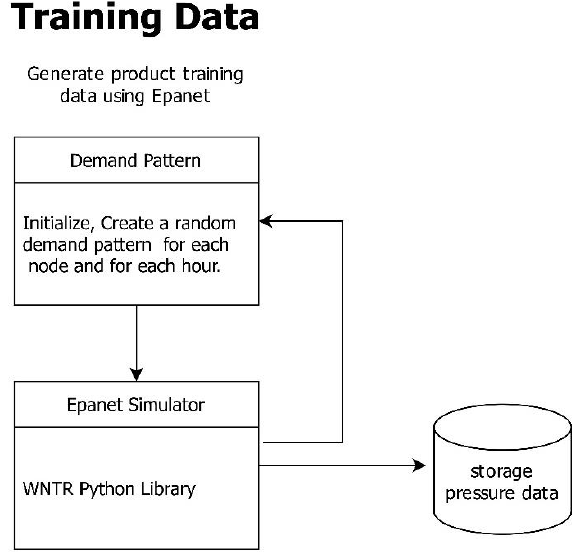
Figure 5. Flowchart of training data procedure.